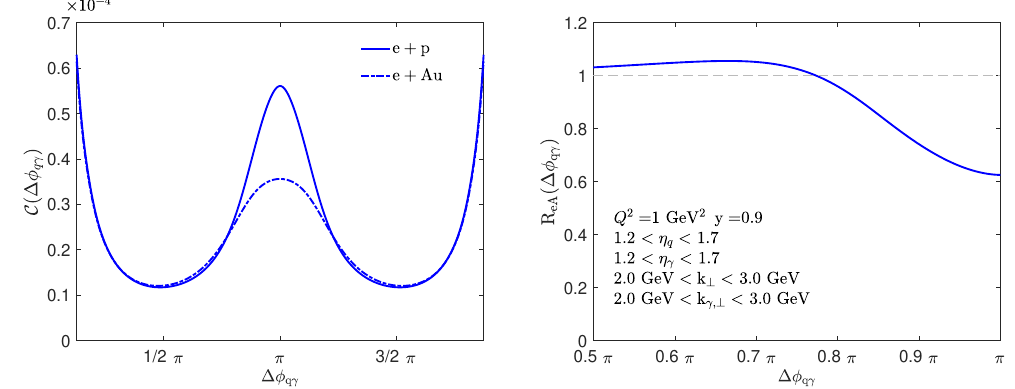
Figure 3 . Left: the azimuthal correlator (defined in eq. (6.3)) as a function of the relative azimuthal angle ∆ φ qγ between the direct photon and the quark in e + p and e + Au collisions. Right: the ratio R eA (see eq. (6.11)) of azimuthal angle correlations in e + Au relative those in e + p collisions as a function of ∆ φ qγ